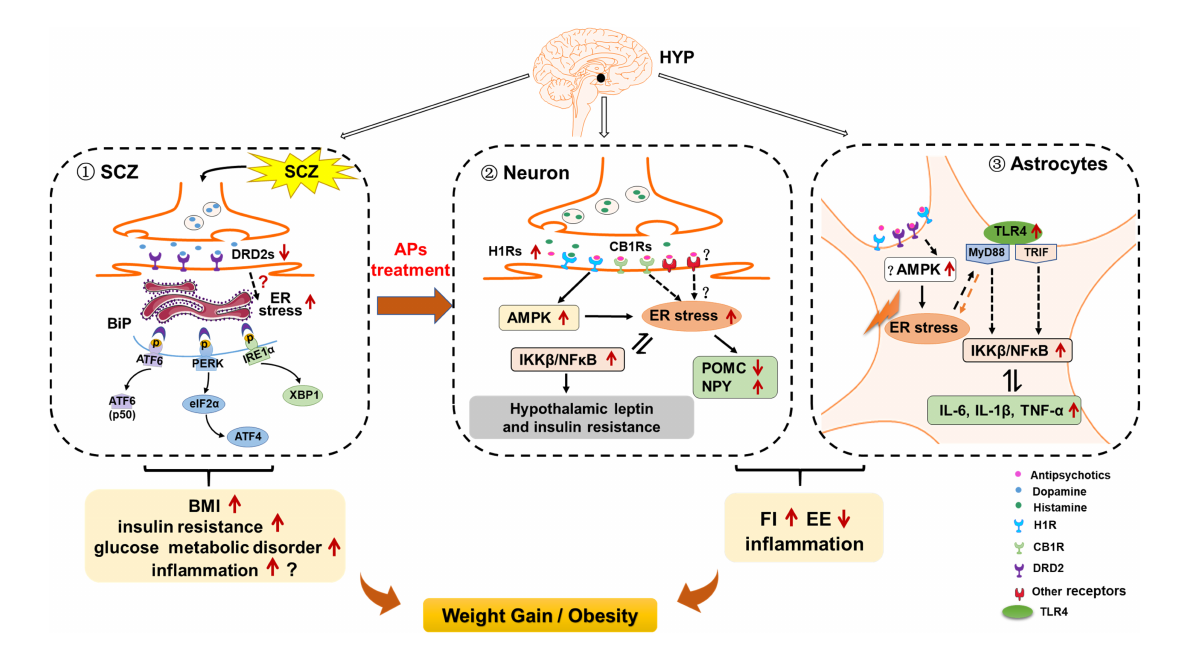
FIGURE3 Possible role of hypothalamic endoplasmic reticulum (ER) stress in schizophrenia (SCZ)- and antipsychotic-induced weight gain/obesity. (1) Hypothalamic ER stress may be activated by decreased dopamine receptor D2 (DRD2) signaling, and these effects may be related to SCZ-related upregulation of body mass index (BMI), insulin resistance, and other metabolic disorders. Activated ER stress may also induce neuroinflammation; these effects may also be related to SCZ and its associated metabolic disorders. (2) In hypothalamic neurons, ER stress may contribute to antipsychotic-induced weight gain by inducing hyperphagia, decreasing energy expenditure, and inducing inflammation. Antipsychotics such as olanzapine and clozapine may activate hypothalamic ER stress by affecting H1 receptors (H1R) and CB1 receptors (CB1R), and activating adenosine 5 (cid:48) -monophosphate (AMP)-activated protein kinase (AMPK). On the one hand, activation of ER stress may inhibit proopiomelanocortin (POMC) processing, attenuate leptin signaling, and increase neuropeptide Y (NPY) and agouti-related protein (AgRP) expression, leading to increased food intake; reduced brown adipose tissue (BAT) thermogenesis and white adipose tissue (WAT) browning; increased inflammation; and thus weight gain/obesity Moreover, antipsychotic-induced ER stress activates inhibitor of nuclear factor kappa-B kinase subunit beta (IKK β )/nuclear factor κ B (NF- κ B) signaling, leading to insulin and leptin resistance, and increased expression of pro-inflammatory cytokines such as interleukin 6 (IL-6), IL-1 β , and tumor necrosis factor alpha (TNF- α ). These effects may also contribute